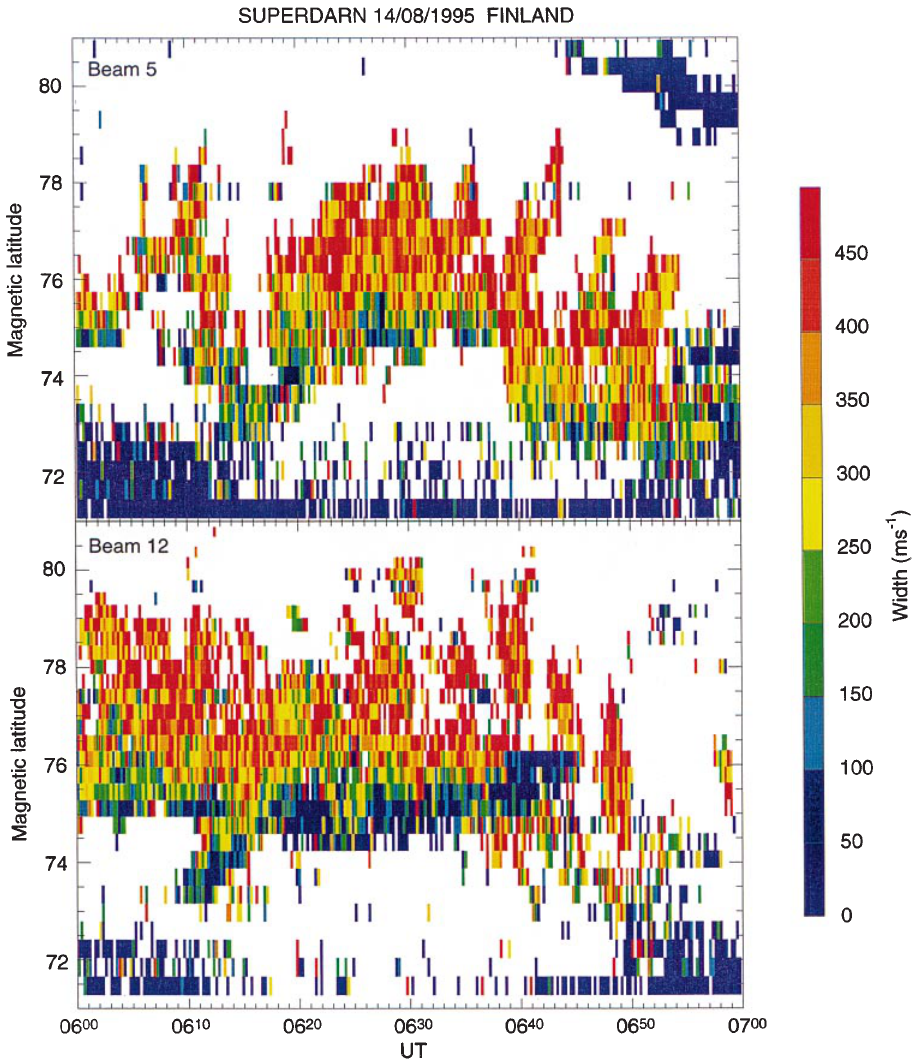
Fig. 4 Latitude-time-spectral- width plot for beams 5 and 12 between 0600 and 0700 on the 14 August 1995. The spectral width is colour-coded with red velocities indicating the largest spectral width and dark blue representing the smallest